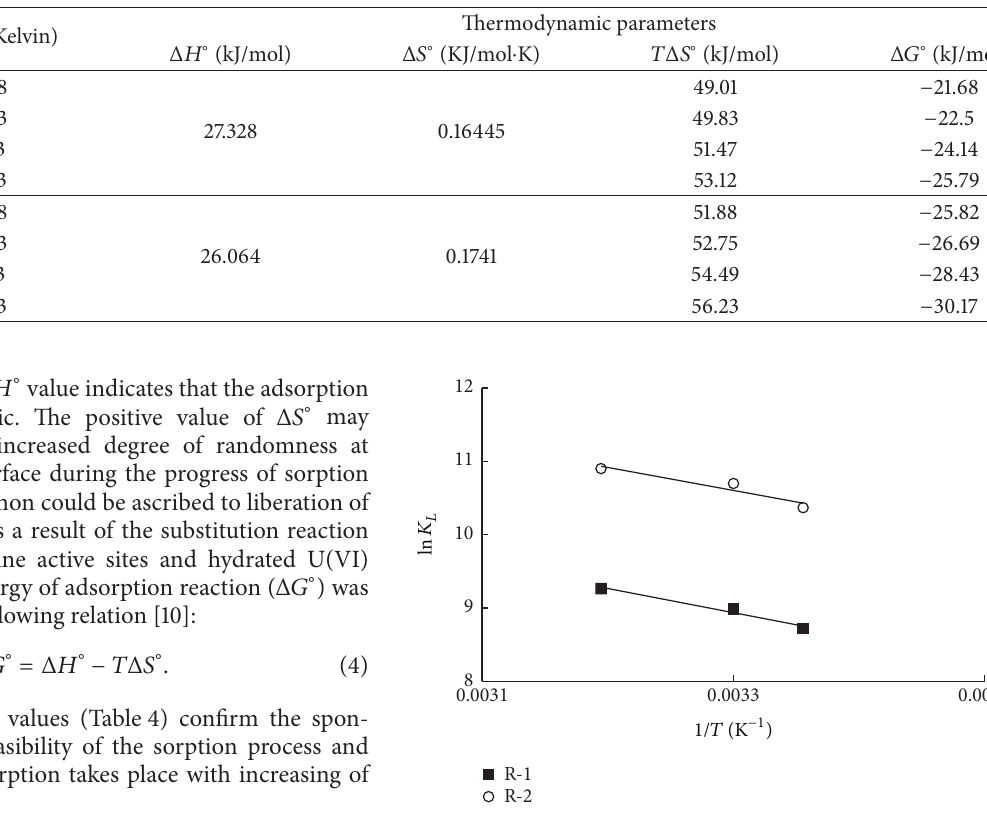
Table 4: Thermodynamic parameters for adsorption of U(VI) by R-1 and R-2 at different temperatures.